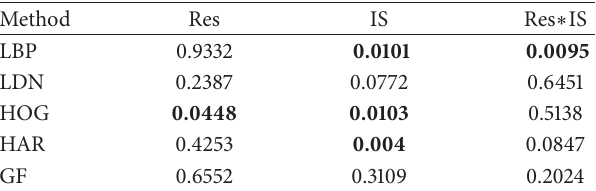
Table 3: Summary of the ANOVA results of pixel resolution and integrationscalewiththeNLSVM(thevalueineachcellisa 𝑝 value).